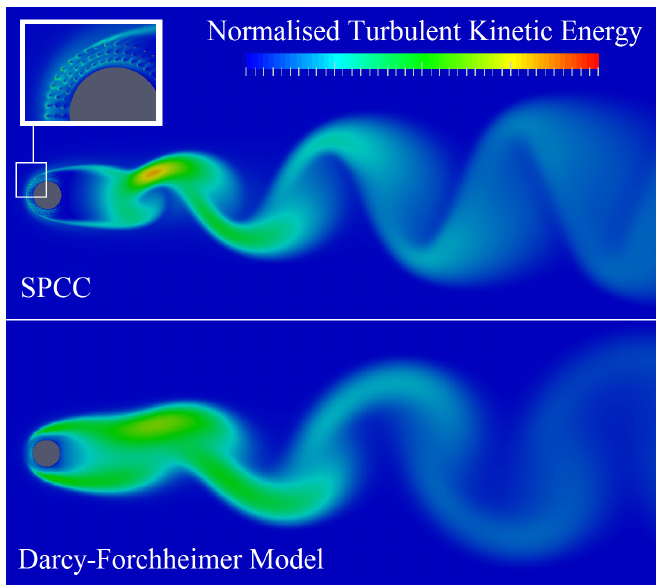
Figure 10. Preliminary CFD result comparing the normalized turbulent kinetic energy distributions of the SPCC with a cylinder using a Darcy–Forchheimer model. Both cylinder model data are normalized to the same scale. Flow is from left to right.